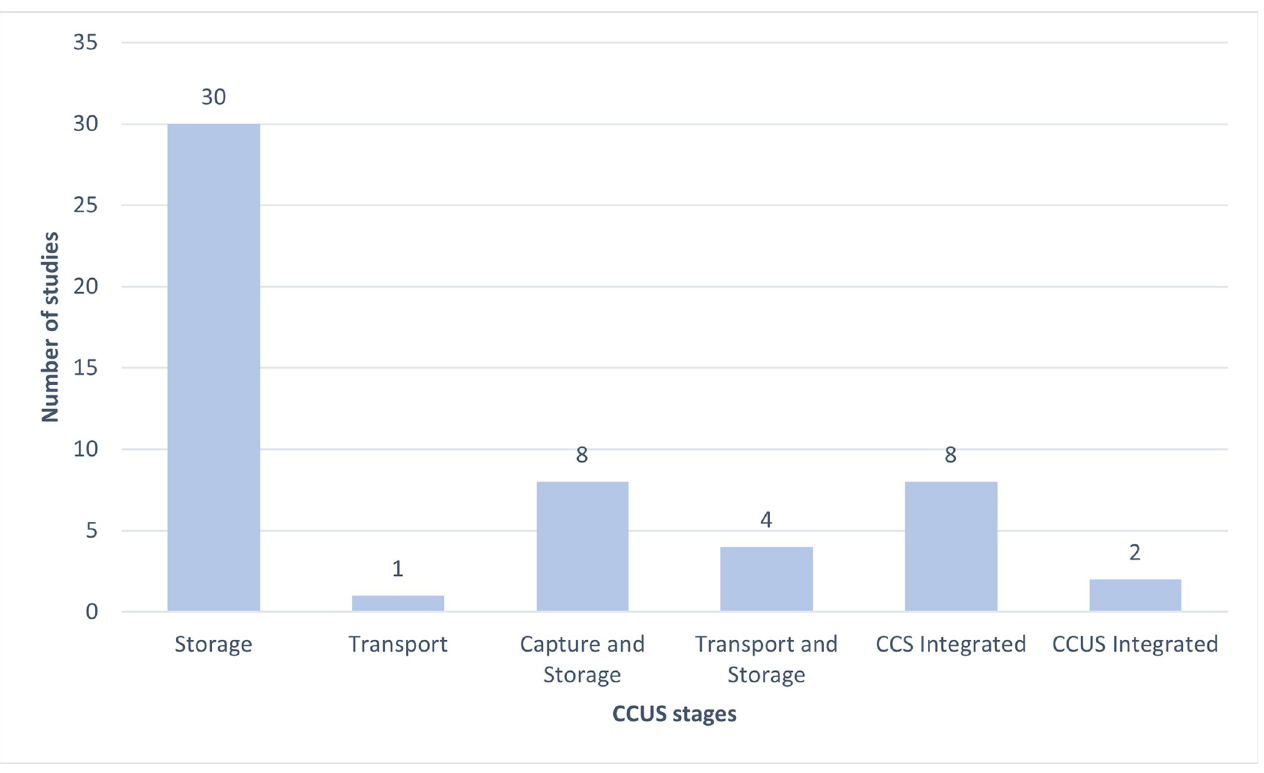
Fig 4. Number of studies per CCUS